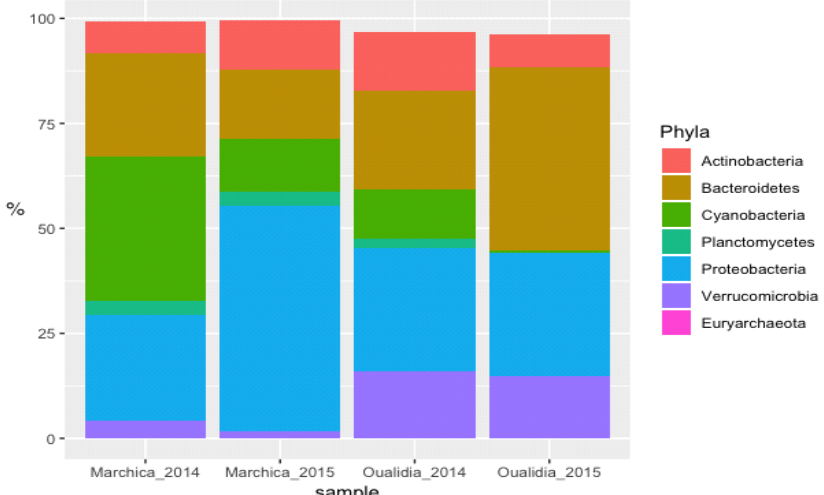
Figure 4. Cross comparison of 16S rRNA amplicon sequences from selected abundant high-level bacterial taxa from Marchica and Oualidia metagenomes. Table 4. 16s rRNA amplicon sequences from selected high abundant sequences assigned to a phy ‐ lum for both sampling campaigns 2014 and 2015 in both lagoons.